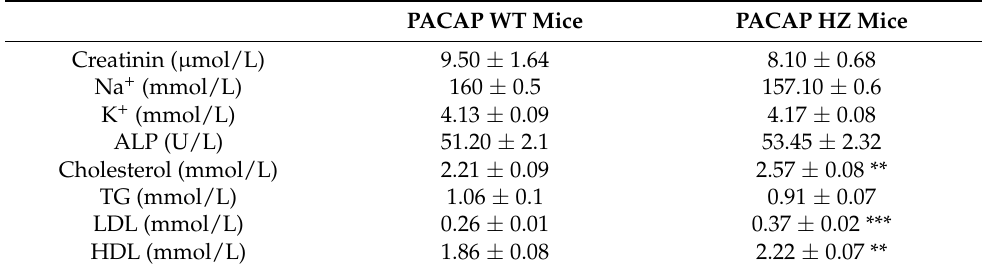
Table 1. Plasma analysis of wild type (WT) and PACAP heterozygous (HZ) mice. Results are